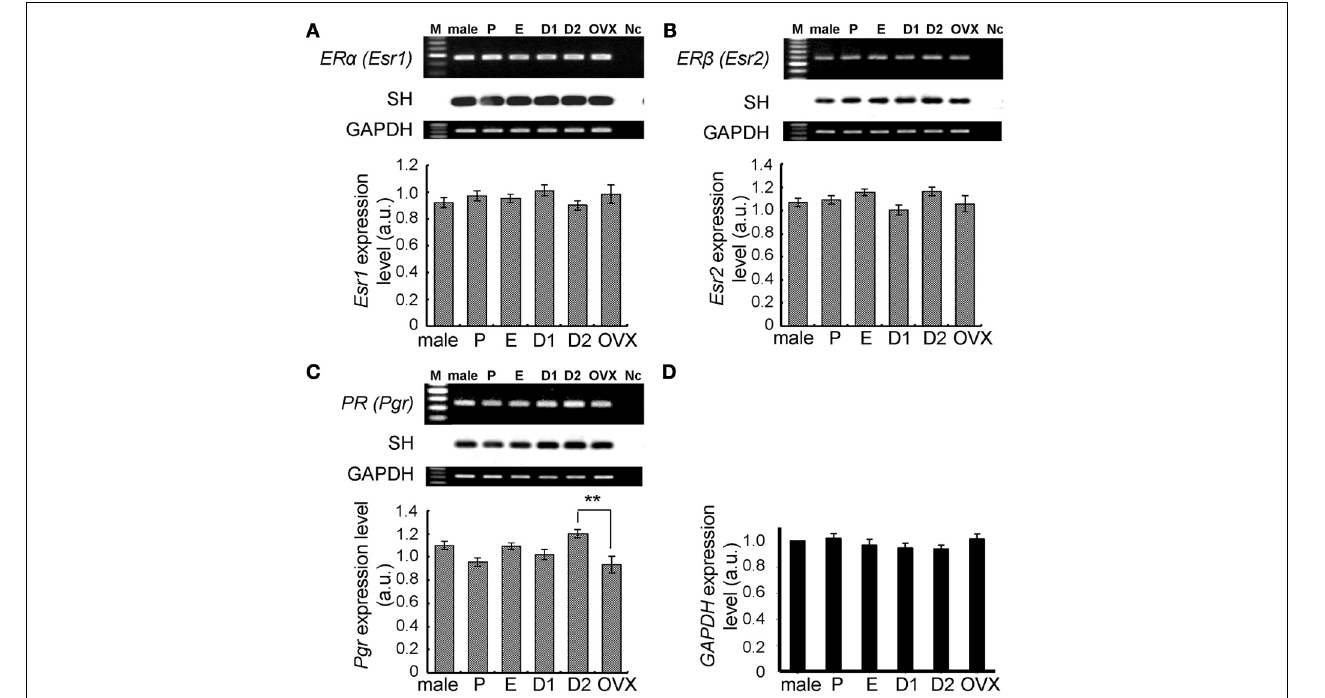
FIGURE 4 | No significant change in expression levels of mRNAs for steroid receptors (ER α , ER β , and PR) and GAPDH in the female hippocampus across the estrus cycle. Upper panels show representative PCR images and lower panels show statistical comparisons. In each images, from left to right, size marker (100bp ladder) (M), male hippocampus (male), female hippocampus at P, E, D1, D2, and OVX female rats, the sample without template DNA as negative control (Nc). Ethidium staining and Southern hybridization (SH) are shown. PCR was performed by using cDNA